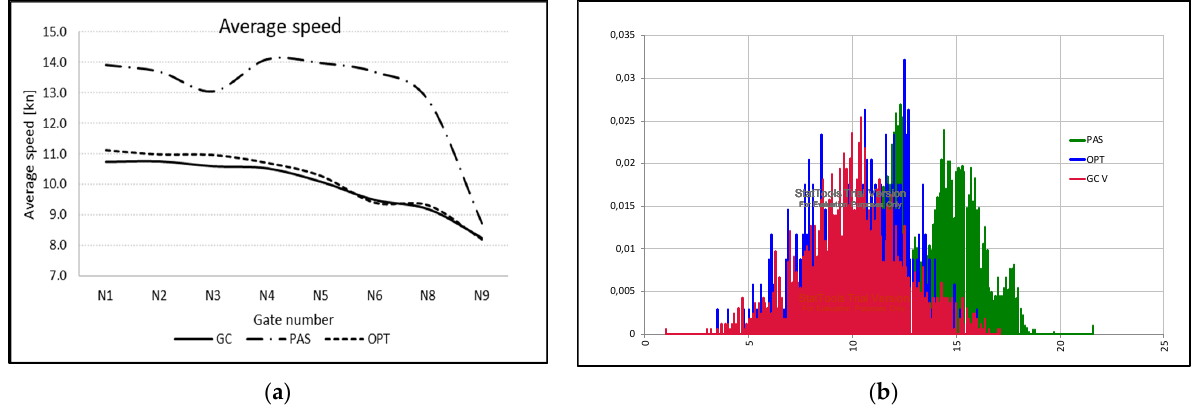
Figure 6. ( a ) Average speed of an incoming vessel; ( b ) Histogram of vessel speeds on N5 for three groups of ships. Figure 6b shows the histogram of ship speed for three groups of ships on the N5 leg.